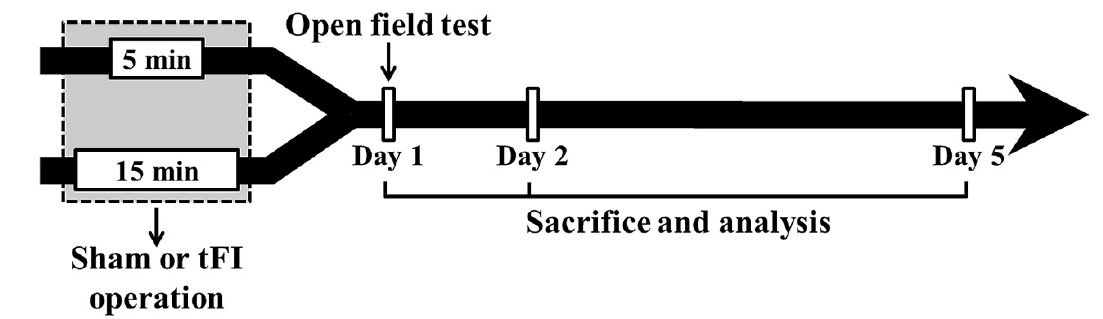
Figure 9. Experimental procedure. Gerbils are given five- and 15-min tFI, respectively, for mild and severe ischemia and reperfusion injury. Open field test (for change of motor activity) was performed on day 1 after tFI, and the gerbils were sacrificed on days 1, 2 and 5 after tFI for the examination of histopathological and biochemical changes.